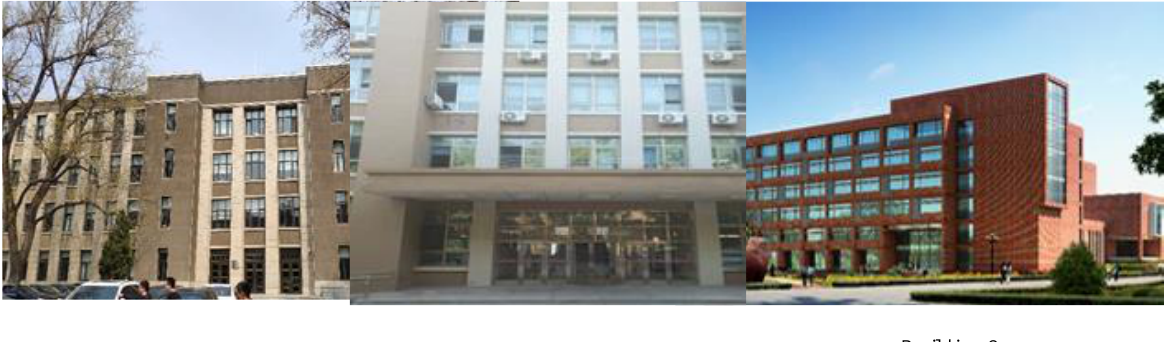
Figure 5. Monitoring buildings (Dalian,